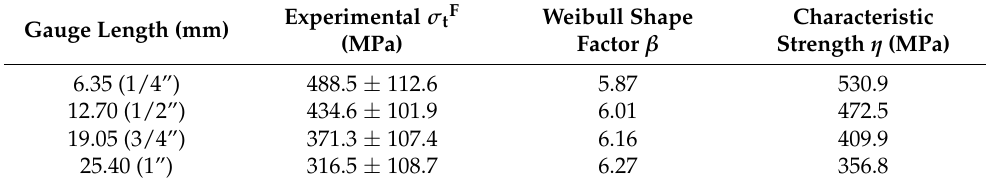
Table 2. Experimental mean intrinsic tensile strengths of the abaca fibers, and the Weibull analysis